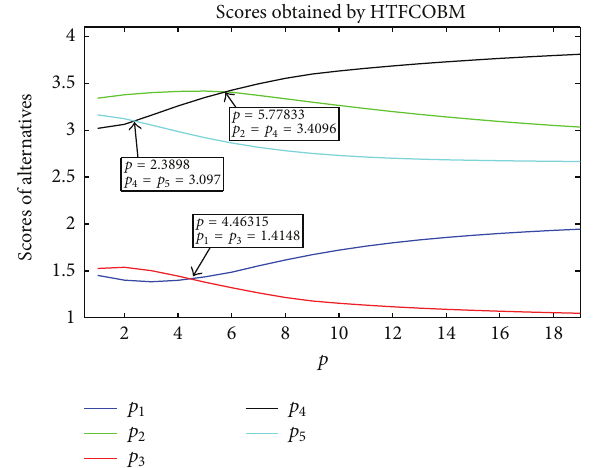
Figure 1: Scores for theses obtained by HTFCOBM operator.